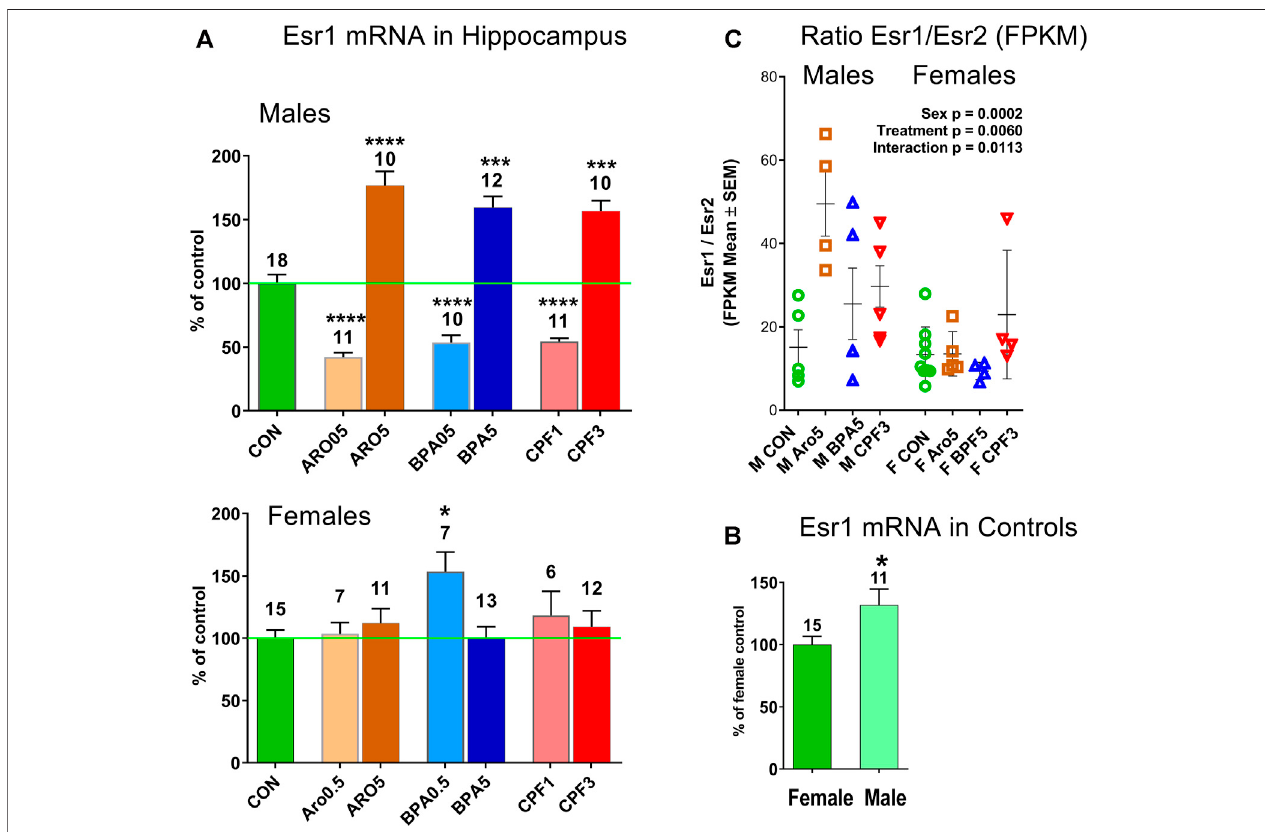
FIGURE 5 | (A) Estrogen receptor-alpha (ER-alpha, Esr1) in hippocampus of male and female offspring at postnatal day 6. Quantitative RT PCR, mean ± S.E.M, number of samples. ANOVA, **** p < 0.0001, *** p < 0.001, * p < 0.05. (B) Esr1 mRNA level is higher (131.8%) in male than female hippocampus. Quantitative RT PCR, mean ± S.E.M, number of samples. Unpaired t test, p < 0.05. (C) Ratio of ER-alpha (Esr1)/ER-beta (Esr2) in hippocampus of individual male and female offspring is increasedin males bytreatmentwithAro, BPAand CPFat the higher doselevel.RNAseqdata,FPKM (fragments per kilobaseper million reads),two-way ANOVA, treatment p (cid:1) 0.0060, sex p (cid:1) 0.0002, interaction treatment x sex p (cid:1) 0.0113. CON: controls, ARO0.5, ARO5: Aroclor 1254 0.5 mg/kg and 5 mg/kg, BPA0.5, BPA5: bisphenol A 0.5 mg/kg and 5 mg/kg, CPF1, CPF3: chlorpyrifos 1 mg/kg and 3